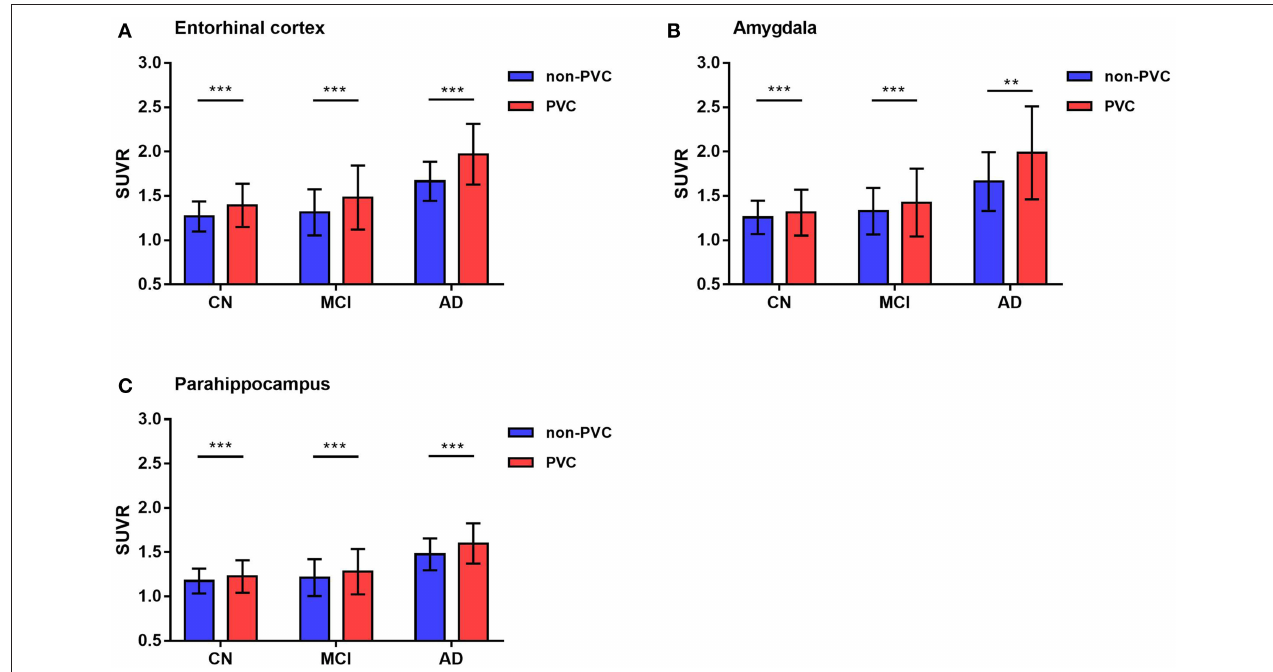
FIGURE 3 | Representative 18 F-AV1451 SUVRs comparison with or without PVC. Bar graphs showing ROIs SUVR (mean with error bars depicting SD) comparison between PVC and non-PVC in entorhinal cortex (A) , amygdala (B) and parahippocampus (C) . P -value was defined using paired t -test to compare SUVR between PVC and non-PVC images in CN, MCI, and AD groups. ** p < 0.01, *** p <